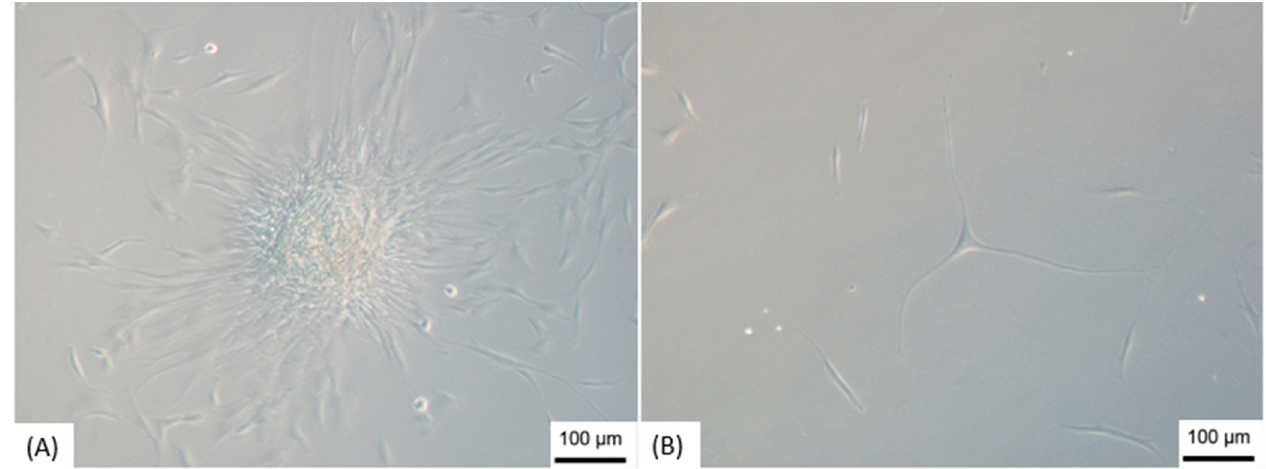
Figure 3. Dissociation of neurospheres. ( A ) Cells dissociating from the neurosphere; ( B ) Cells after dissociation. Note: Images obtained by inverted optical microscopy, 100×—Axio Vert. A1, Zeiss, Germany). Scale bars, 100 µm.